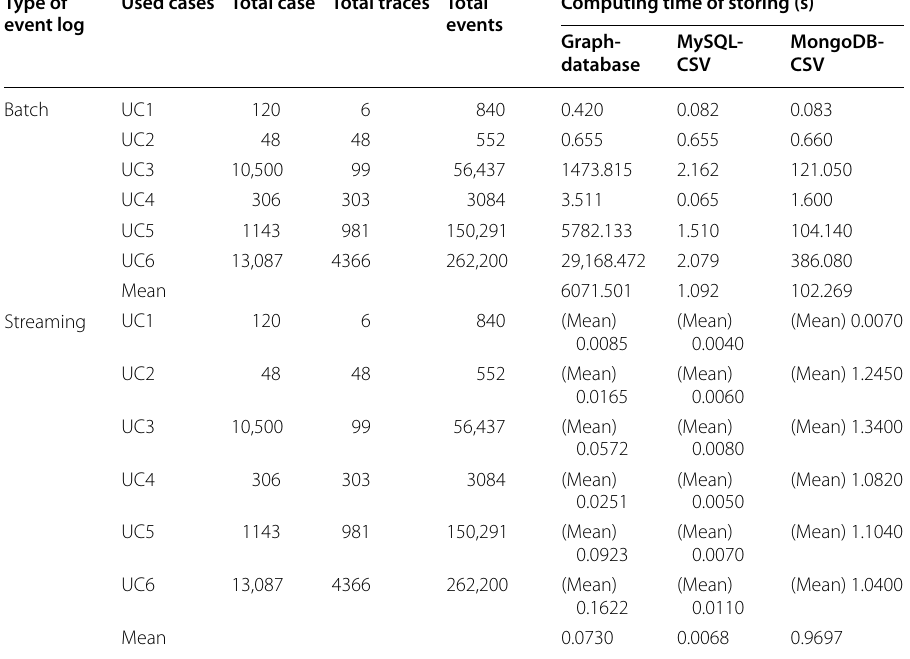
Table 10 Result of storing computing